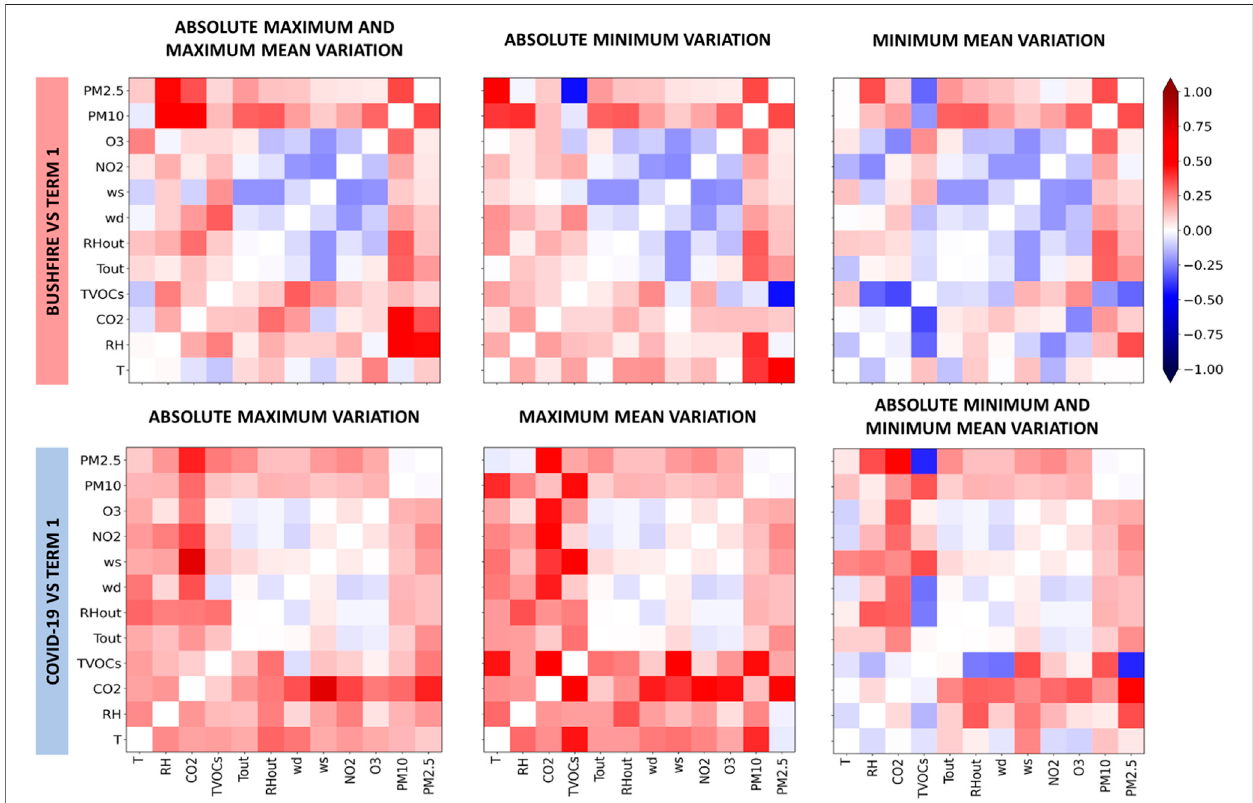
FIGURE 11 | Signi fi cant inter-parameter correlation coef fi cient variation between Bush fi re and Term 1 (upper row) and COVID-19 and Term 1 (lower row) .